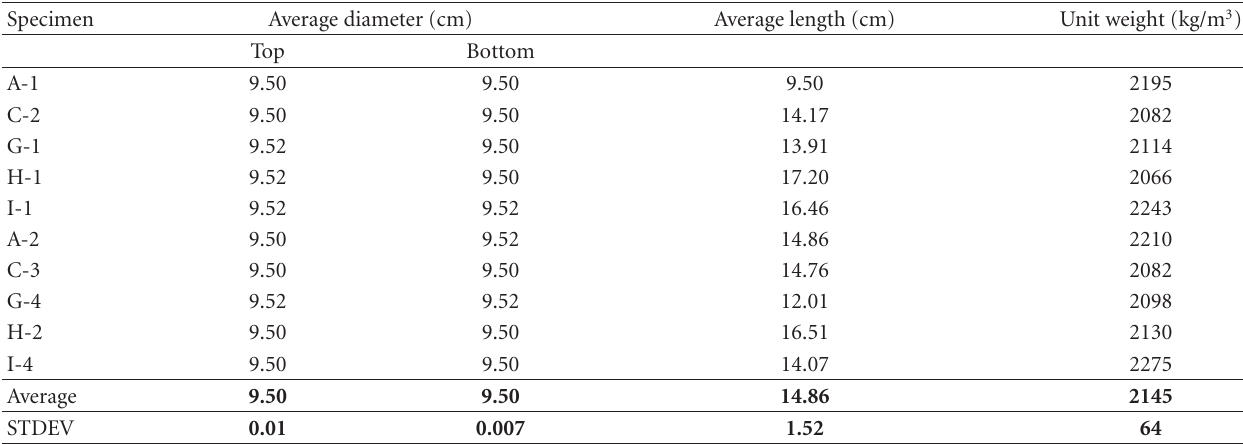
Table 1: Pervious concrete cores sample